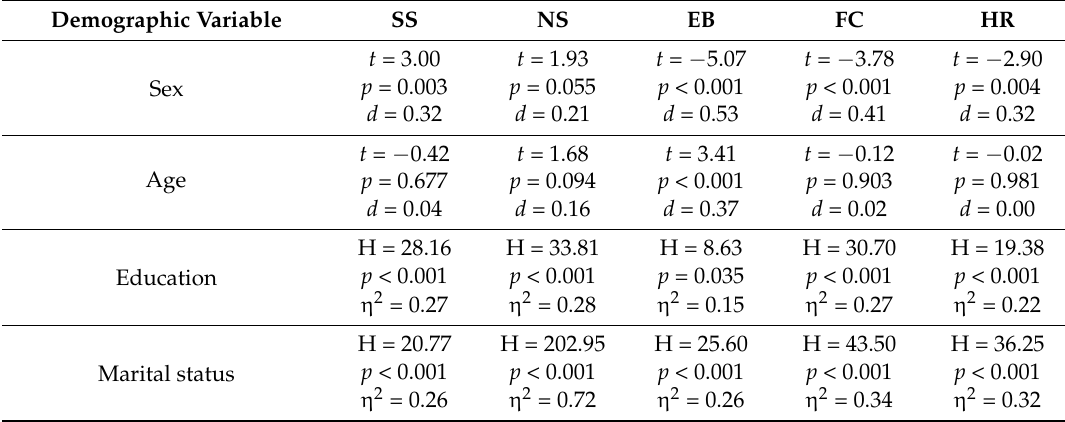
Table 4. Intergroup analysis of structural support in the context of demographic